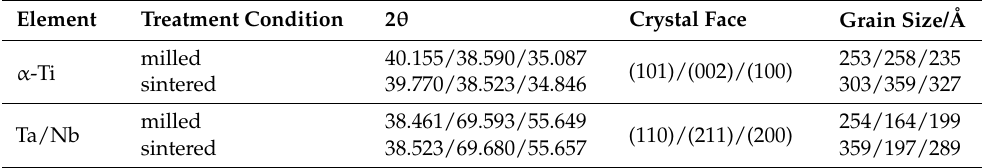
Table 6. Grain size of some phases in 0.5-GNFs nanocomposite calculated by XRD Pattern Processing & Identification